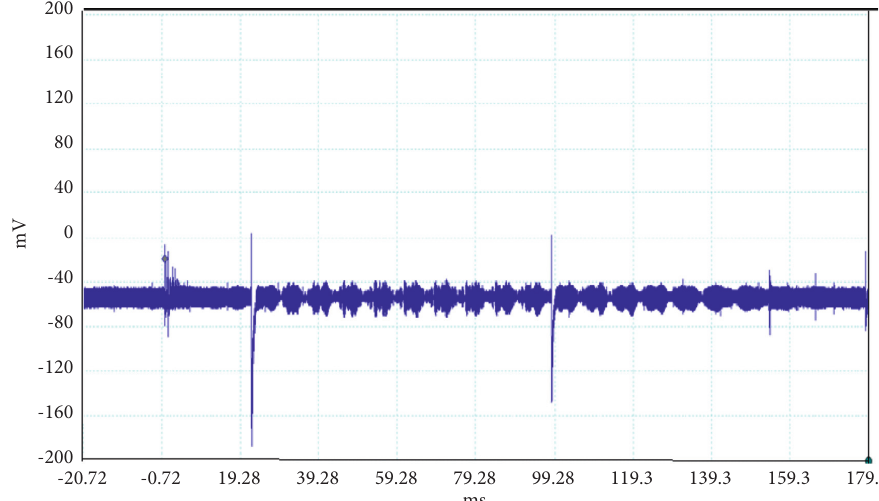
Figure 2: Example of the unusual lightning signal of window size 200ms, which is recorded as a flash number 20150416-0003 in Kathmandu, Nepal.